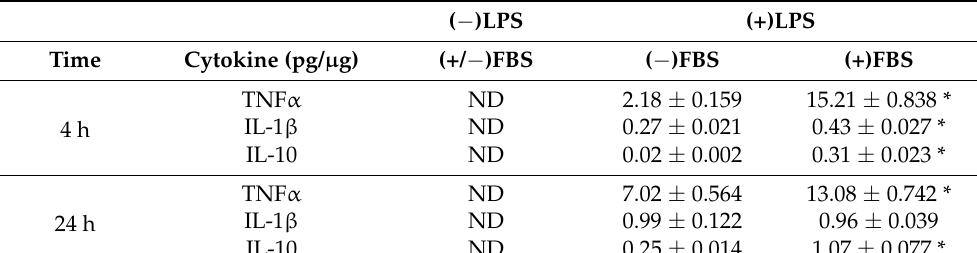
Table 1. Cytokine production (TNF α , IL-1 β and IL-10) in macrophages maintained in ( − )FBS or (+)FBS for 24 h and then stimulated with LPS (100 and 250 ng/mL) for 4 or 24 h. The results are expressed as mean ± SEM of n = 9 cultures. The asterisk (*) denotes significant differences ( p < 0.05) between ( − )FBS and (+)FBS. ND, not detected.